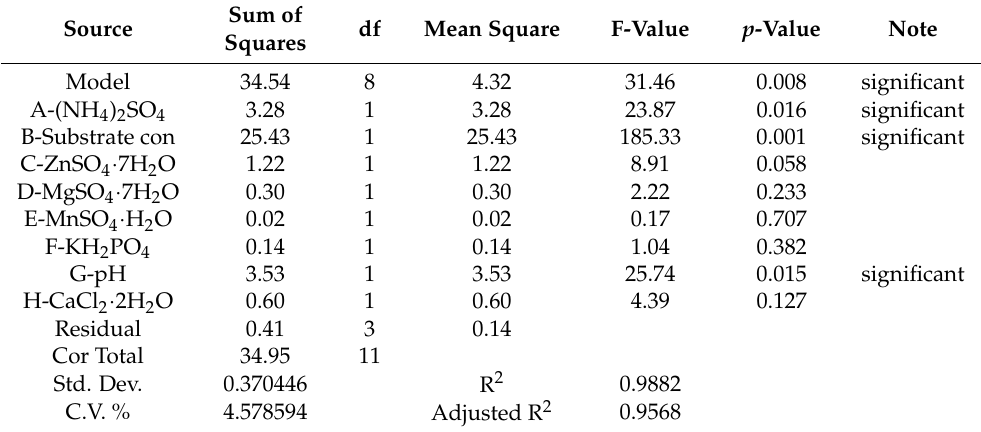
Table 3. Analysis of variance of PB design for ethanol production by M. guilliermondii